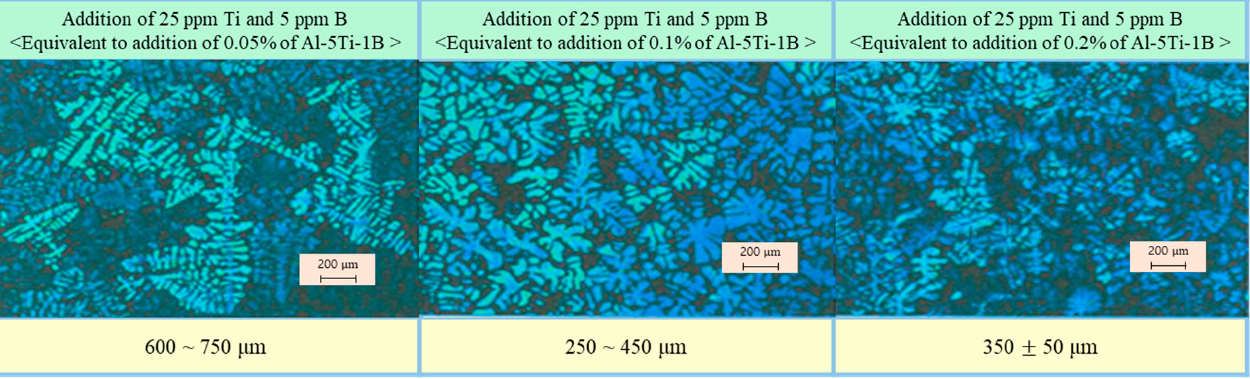
Figure 10. Grain size control for AC4CH alloy by the chemical addition of Ti and B.